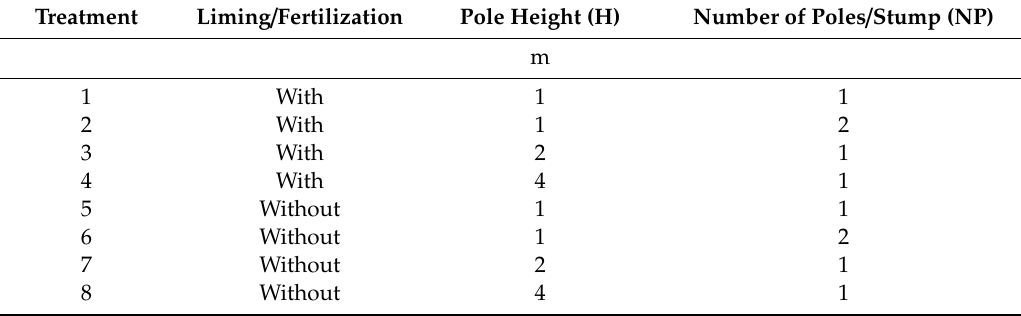
Table 2. Treatments applied in the experimental area cultivated with the clone